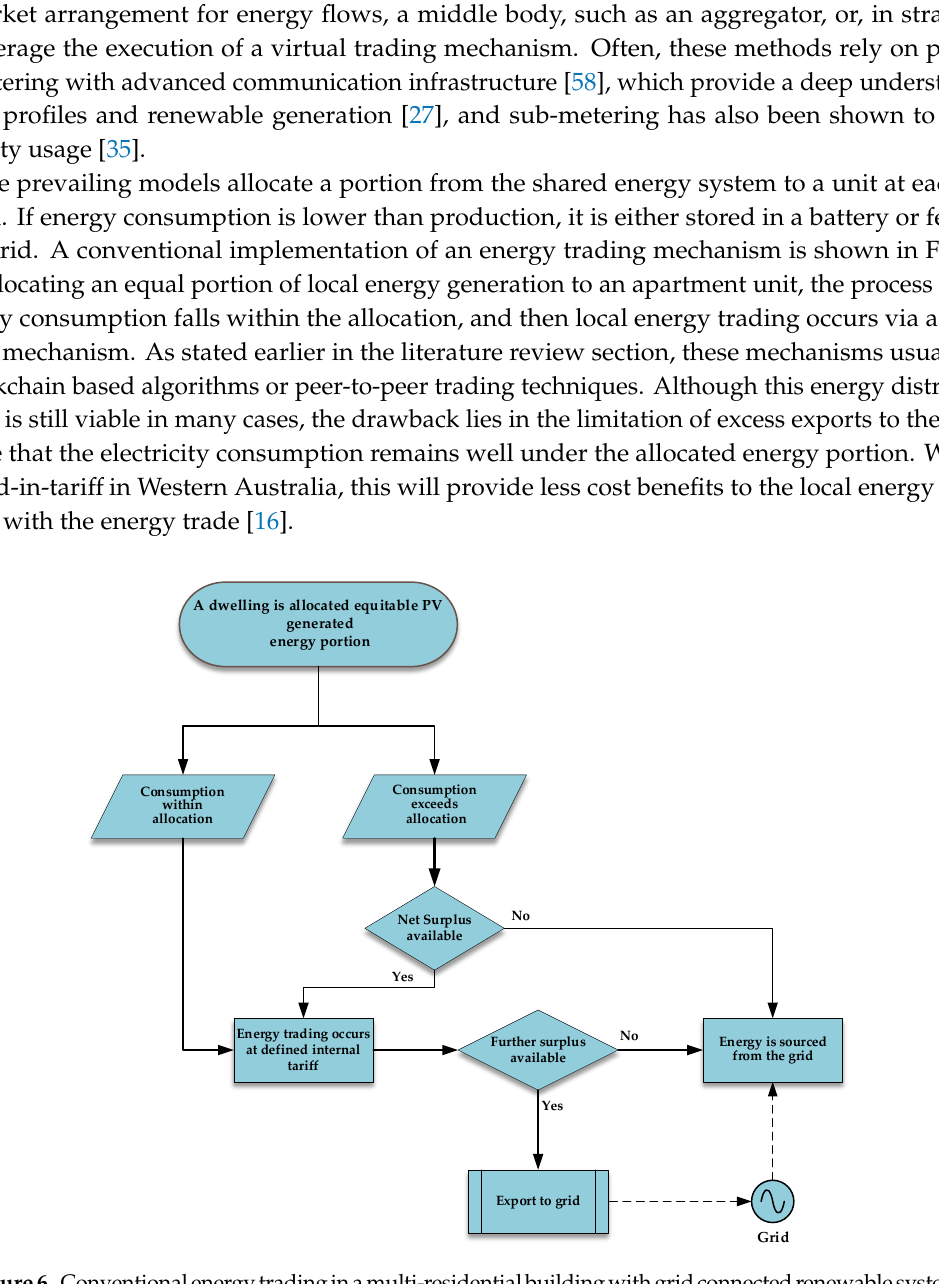
Figure6. Figure 6. Conventional energy trading in a multi-residential building with grid connected renewable system.